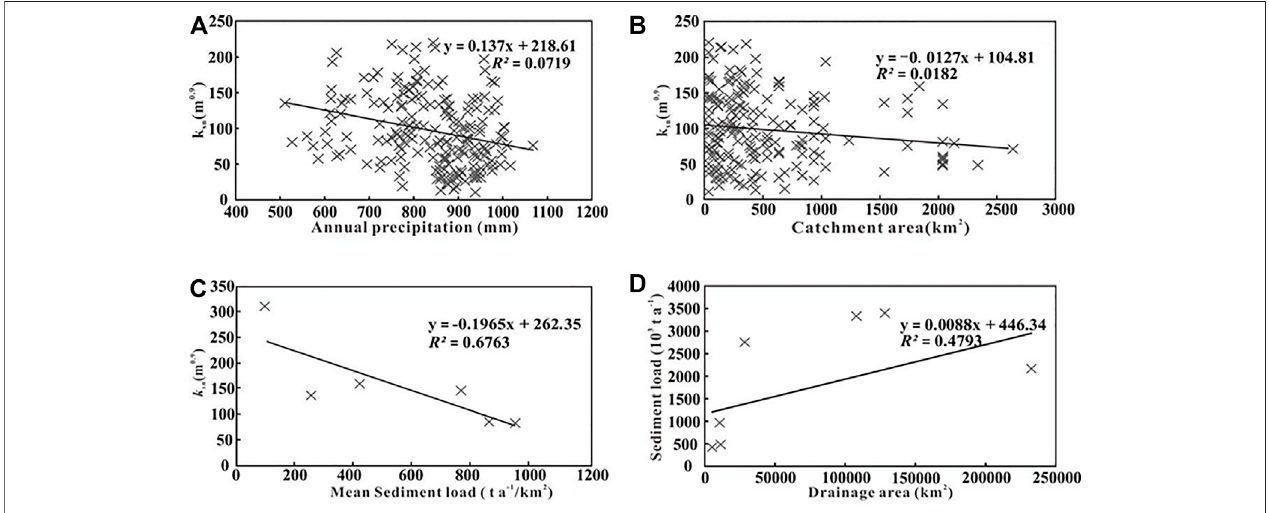
FIGURE10| Bi-variantlinearregressionofchannelsteepness( k sn ) – annualprecipitation (A) ,channelsteepness – catchmentarea (B) ,meansedimentload – channel steepness (C) , and sediment load – drainage area (D) .